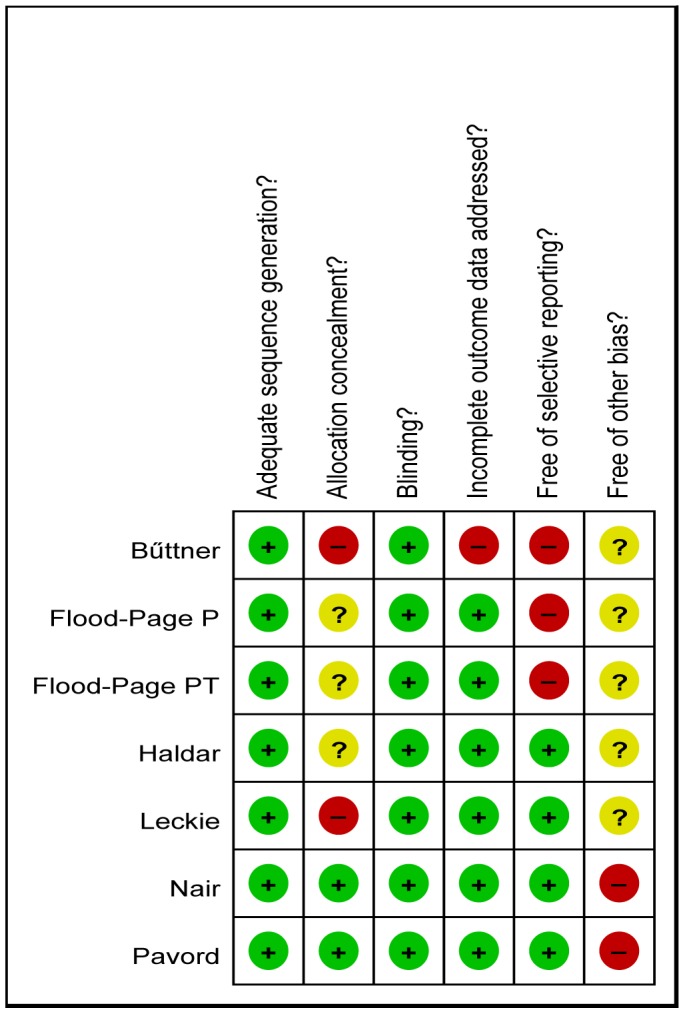
Risk of bias summary of included studies summary*.*Review authors’ judgments about each risk of bias item for each included study.+is “yes”, 2 is “no”,? is “unclear”.